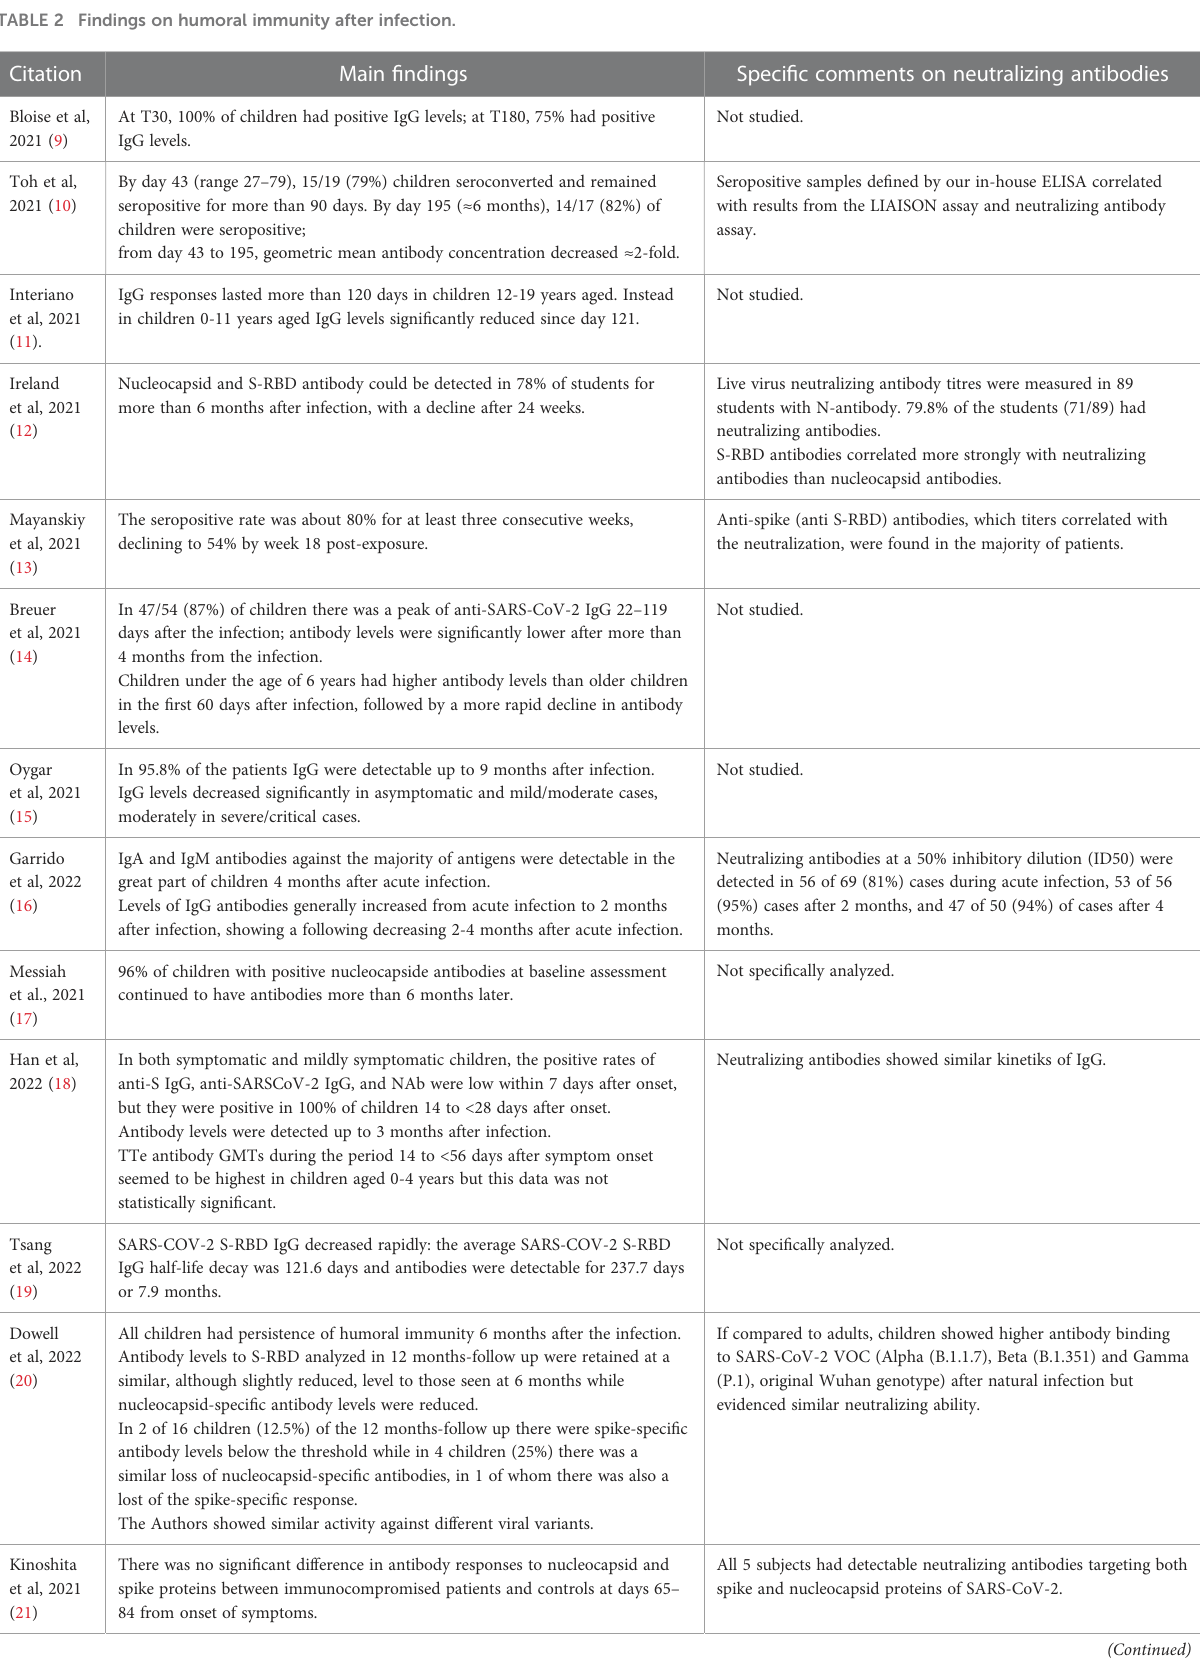
TABLE 2 Findings on humoral immunity after